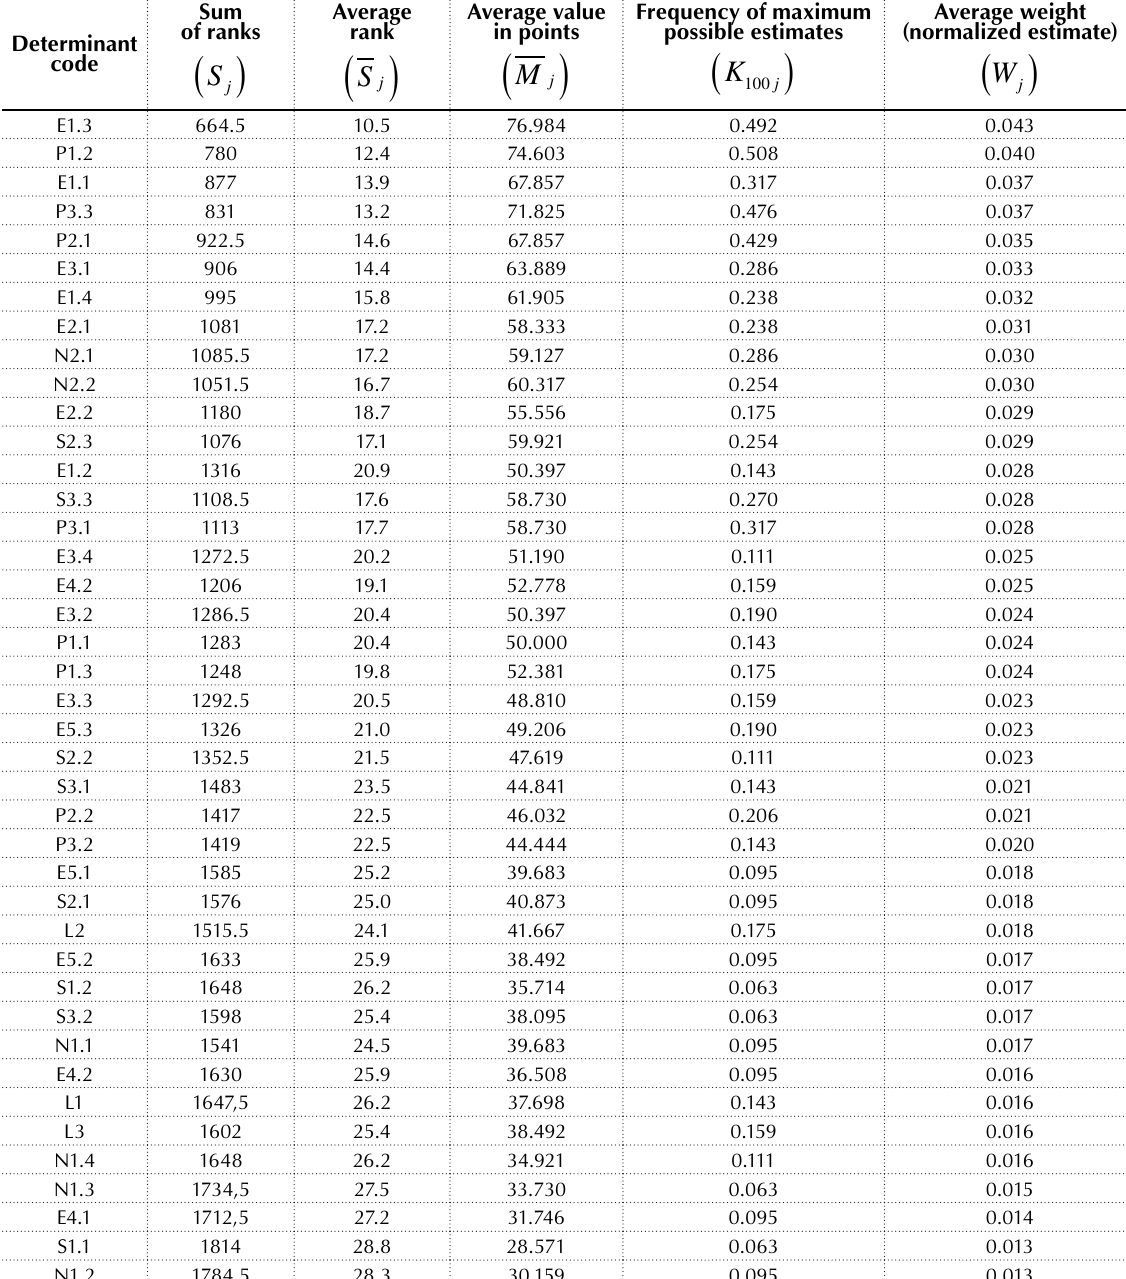
Table 4. Summary of indicators of respondents’ assessing the determinants influence on their migration motivation Determinant